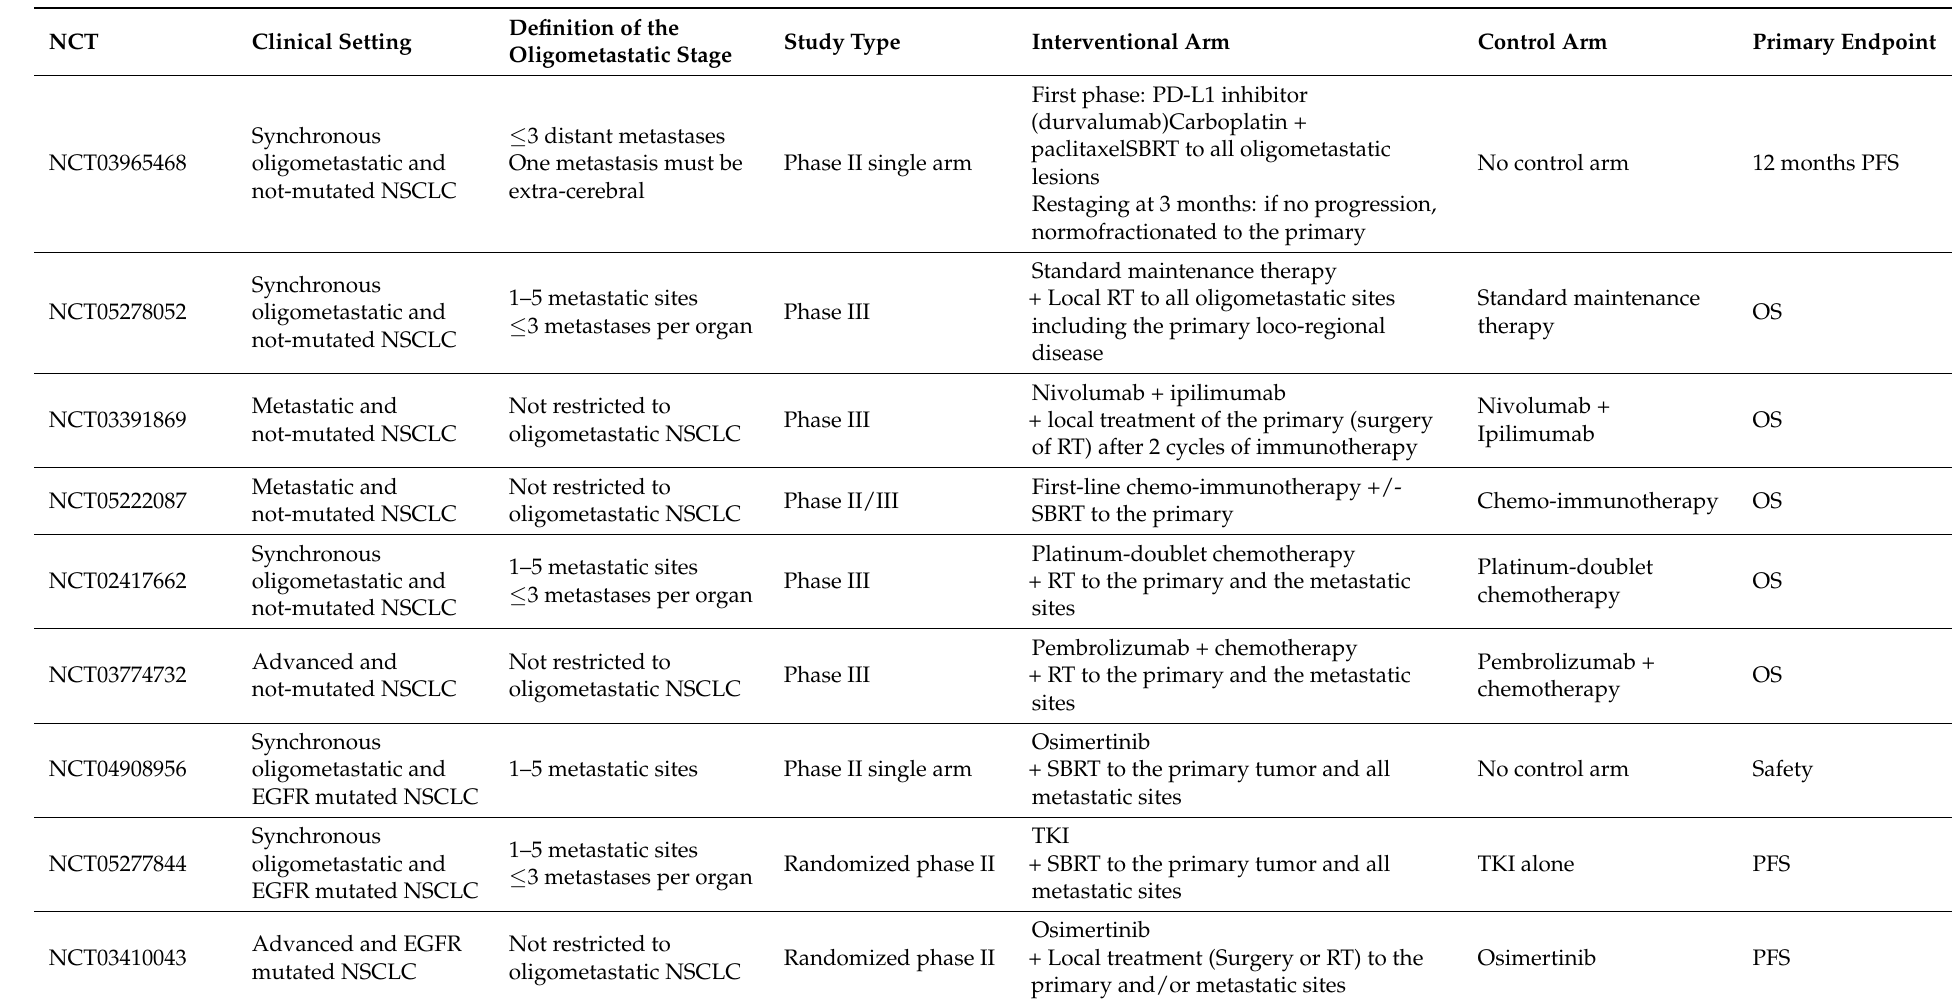
Table 6. Overview of currently ongoing prospective trials in metastatic NSCLC patients, irrespective of the mutational